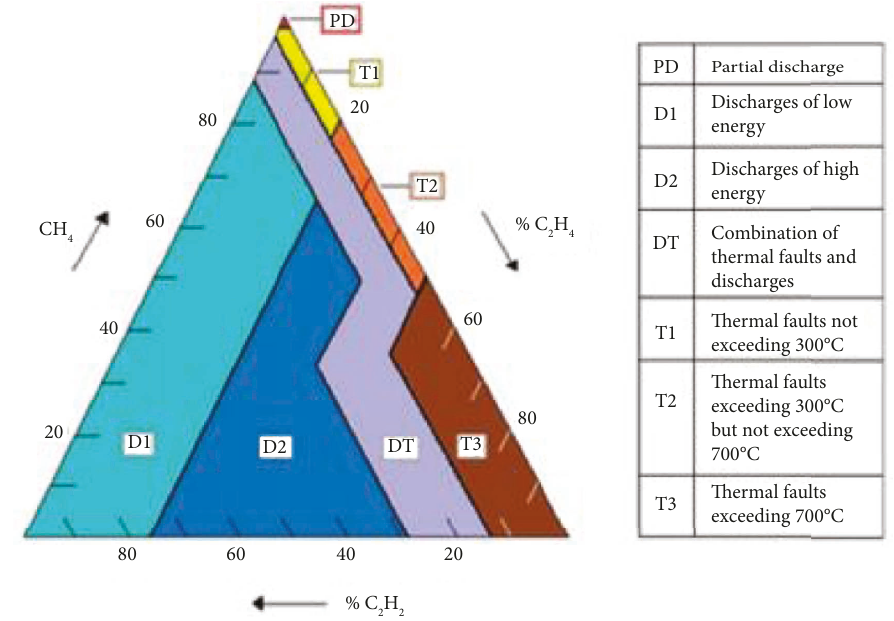
Figure 6: Typical Duval triangle